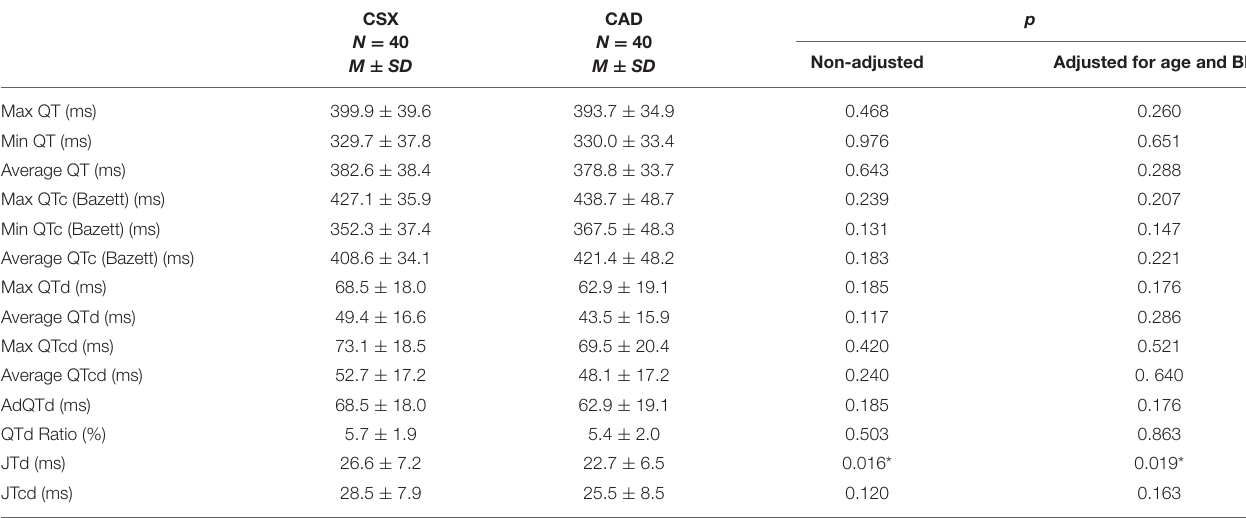
TABLE 2 | Comparisons of QT derived values between CSX and CAD patients.